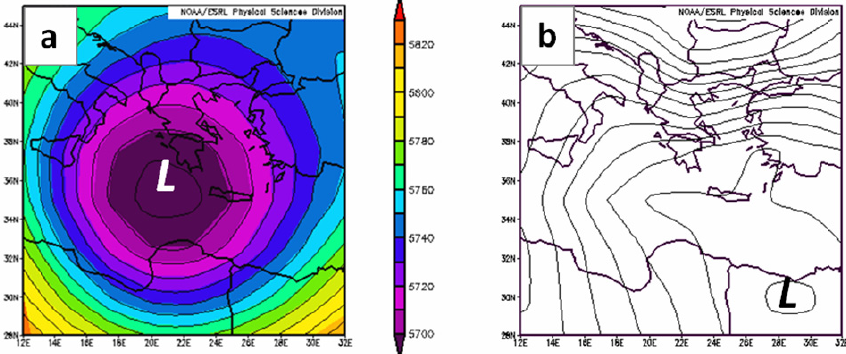
Fig. 6. The synoptic situation, averaged over 9–11 October 2006. (a) 500hPa and (b) slp.